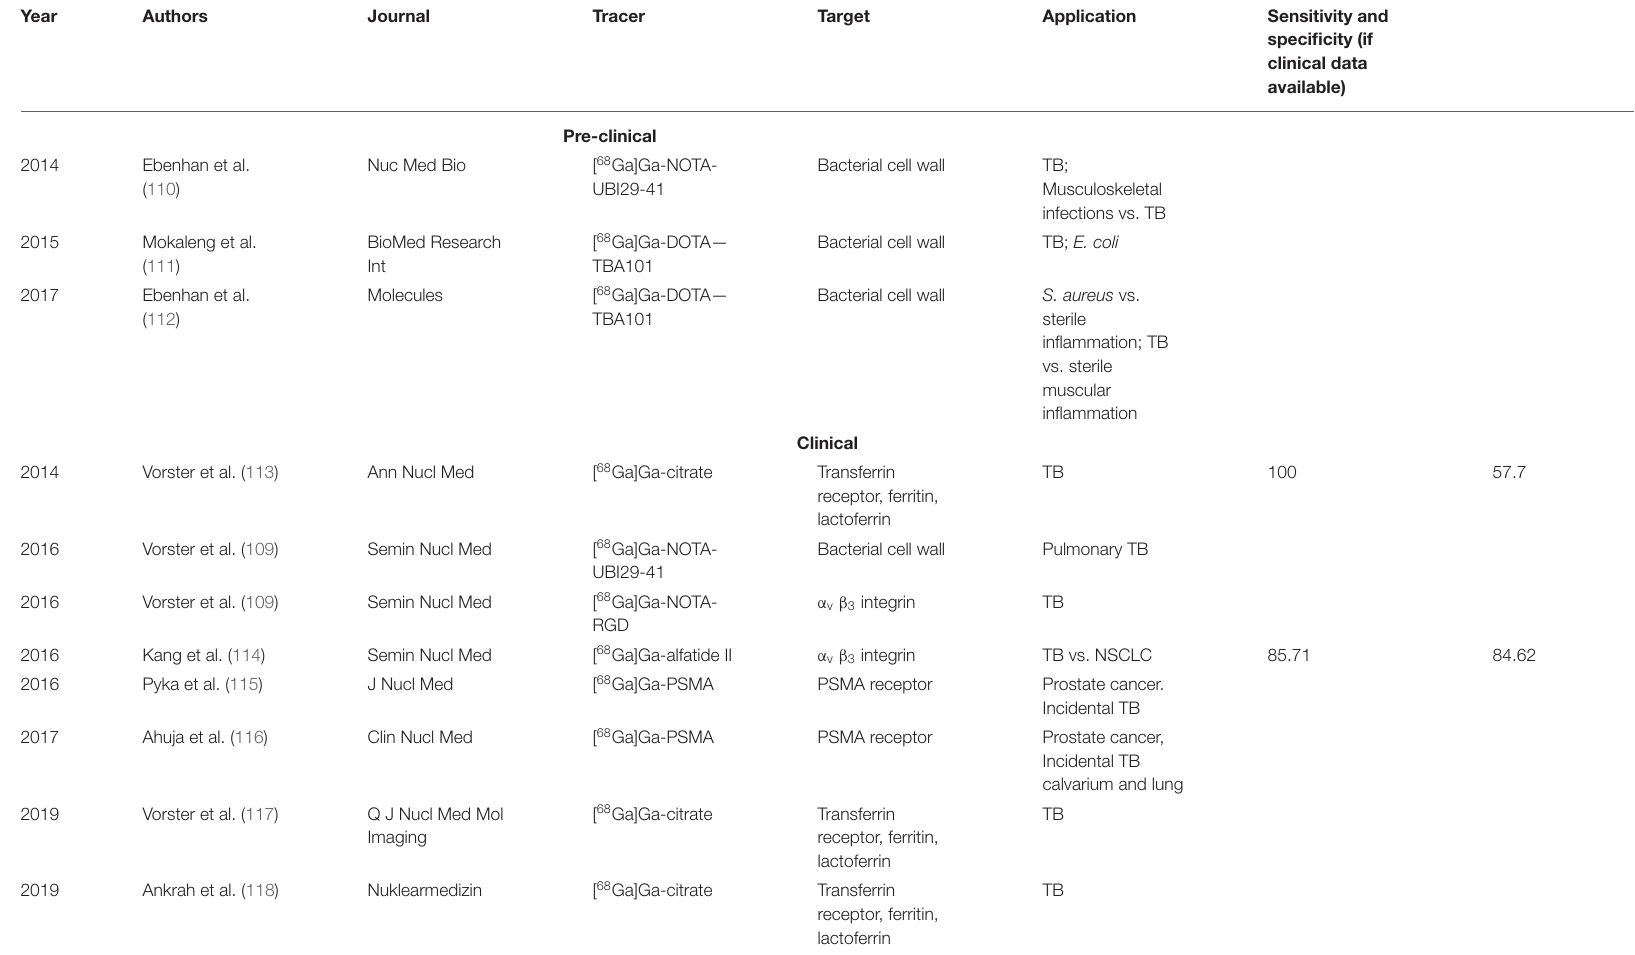
TABLE 2 | Infection imaging with Gallium-68-labelled